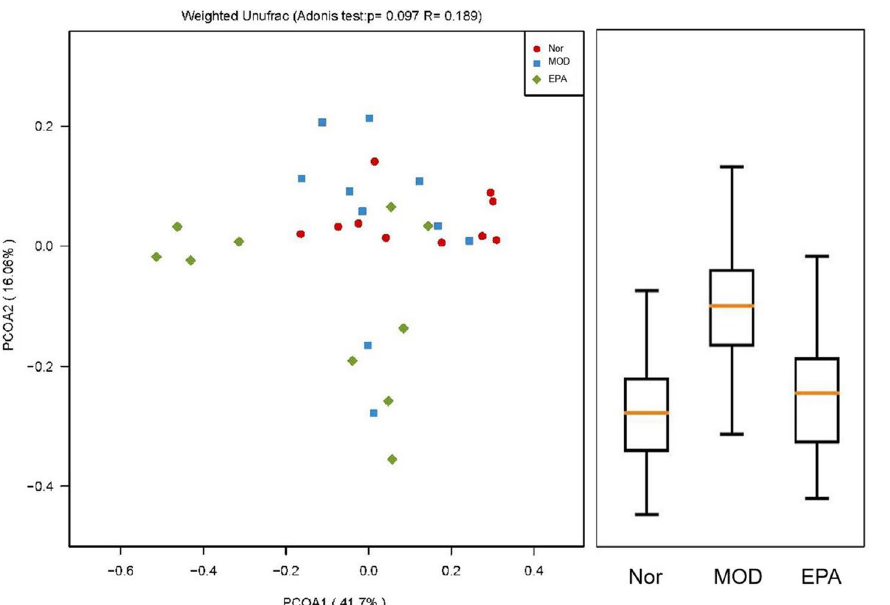
Figure 12. Principal coordinates analysis (PCoA) analysis of gut microbiota based on Weighted Unifrac distance. It illustrated the difference in the microbial composition among the